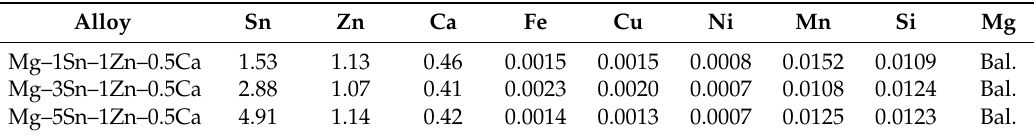
Table 1. Chemical composition (wt.%) of the hot-rolled Mg–xSn–1Zn–0.5Ca (x = 1, 3 and 5 wt.%) alloys